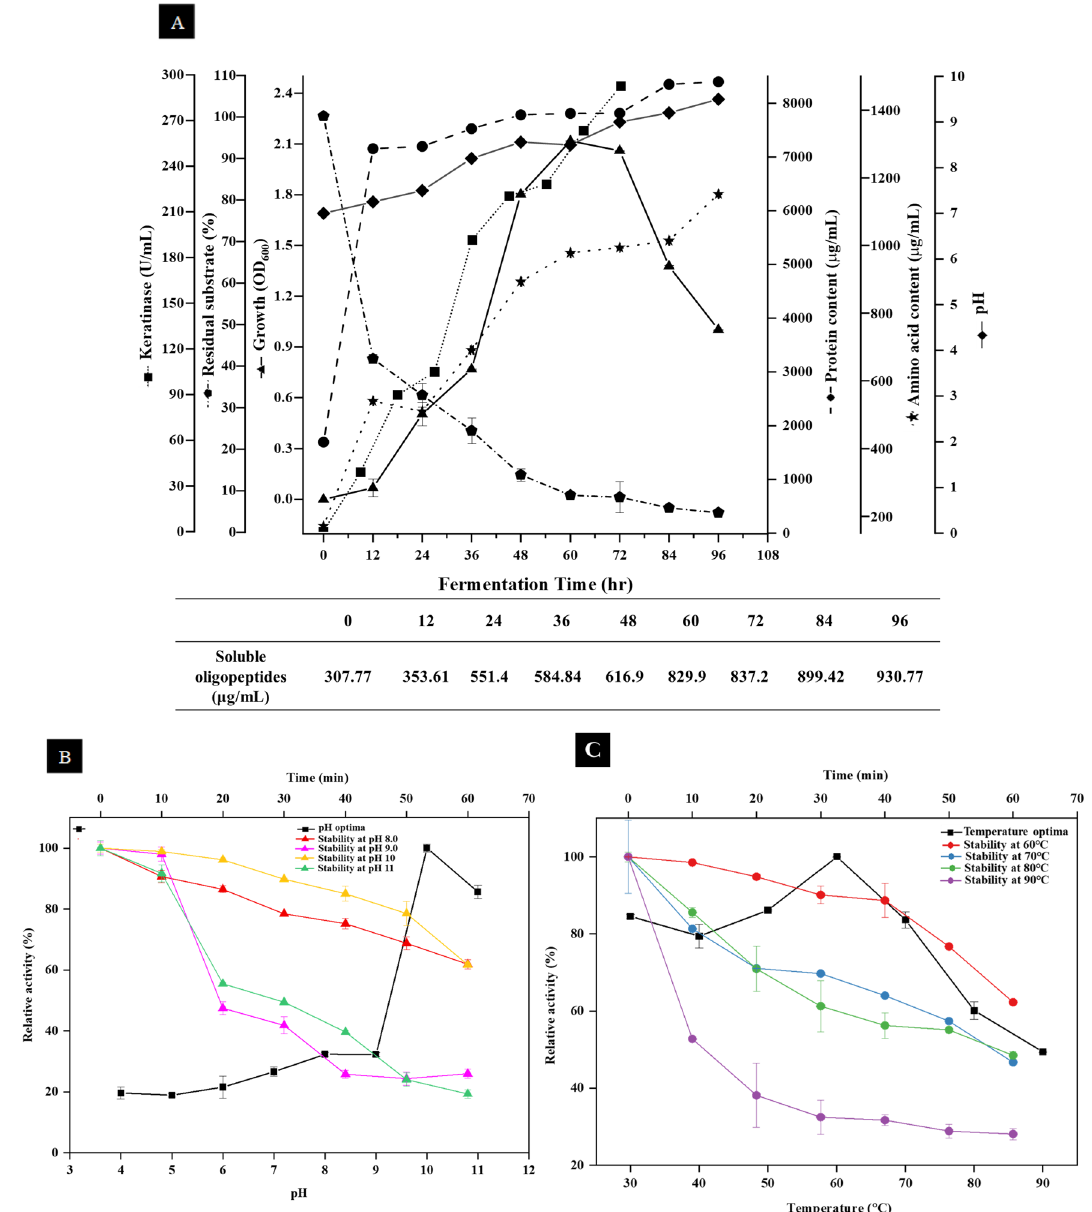
Figure 2. Time course profile of keratinase production ( A ) time course of decomposition of chicken feathers by B. velezensis NCIM 5802 (%), keratinase activity (U/mL), bacterial growth (OD 600 ), soluble protein content (μg/mL), amino acid content (μg/mL) and pH (optimized culture conditions: initial pH 7.0, time 96 h, 3.5% v/v inoculum, 0.625% w/v substrate concentration at 40 °C and 200 rpm). Temperature and pH profile of keratinase produced by B. velezensis NCIM 5802 ( B ) pH optima and stability ( C ) temperature optima and stability. Values represent average of three independent replicates ± standard